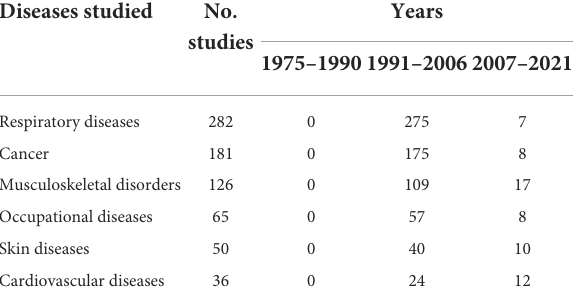
TABLE 3 Diseases studied in domain Public Environmental Occupational Health by study period. Diseases studied